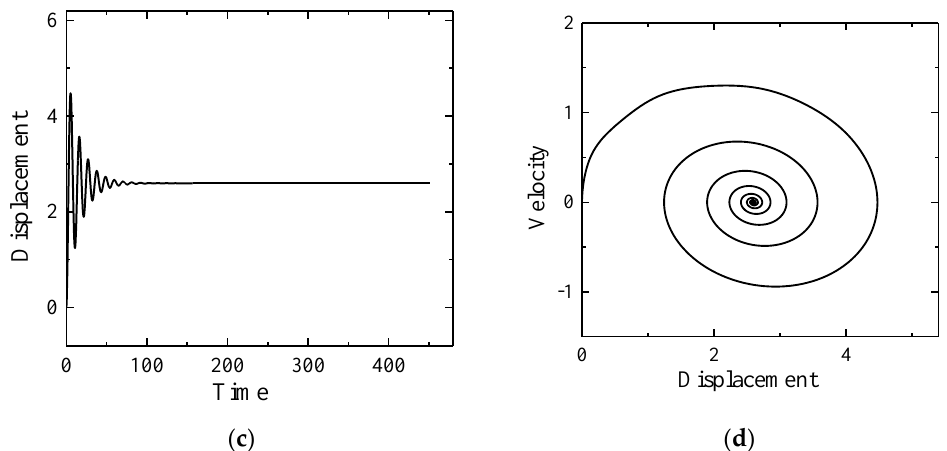
Figure 20. Evolutions of the displacement and speed-displacement diagram of brake disc and brake shoe at the damping of c1 = 0.1 N∙s/m and c2 = 0.4 N∙s/m. ( a ) Evolution of the displacement of the brake shoe. ( b ) Evolution of the speed-displacement diagram of the brake shoe. ( c ) Evolution of the displacement of the brake disc. ( d ) Evolution of the speed-displacement diagram of the brake disc. (4)